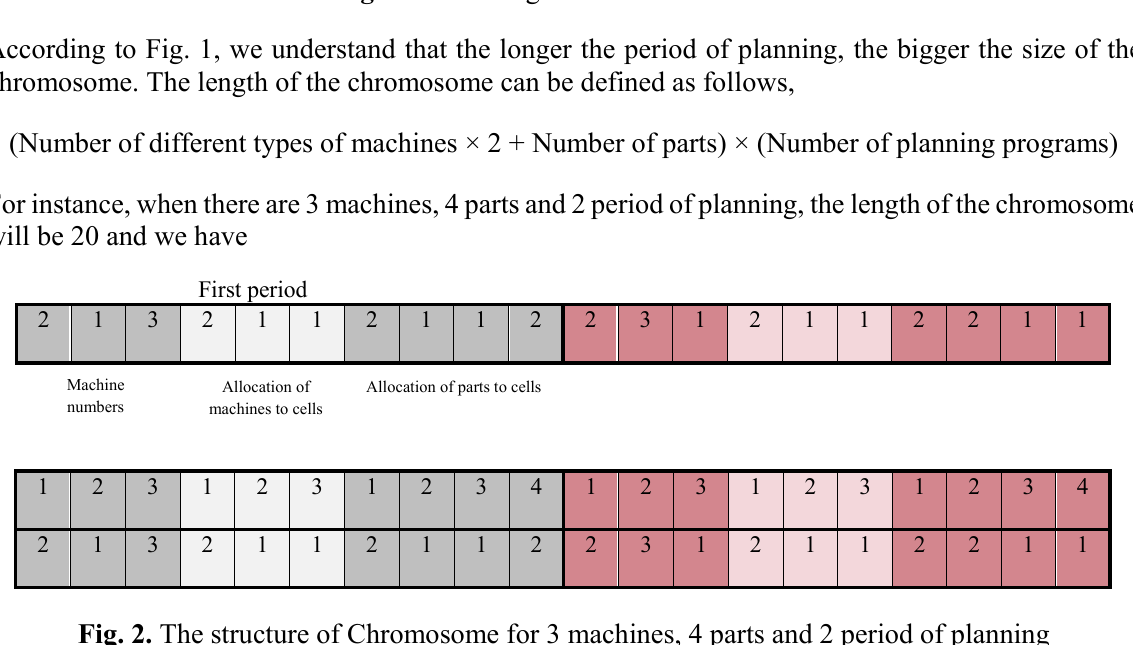
Fig. 1. The arrangement of chromosome